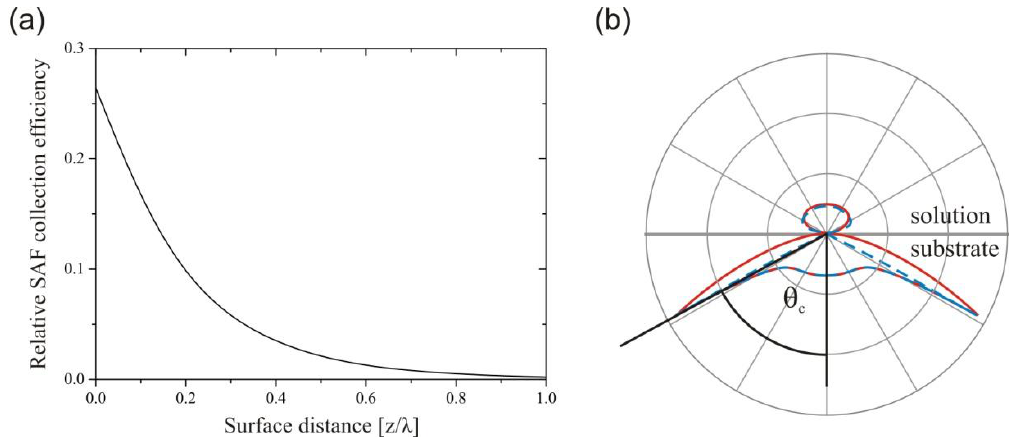
Figure 1. Supercritical angle fluorescence (SAF) emission at the solution/substrate interface. ( a ) The relative SAF collection efficiency of the parabolic element with increasing surface distance z , expressed as a fraction of the emission wavelength, λ. ( b ) Polar plots of the angular emission distribution of a fluorophore with distances z = 0 (red, solid) and z = λ/3 (blue, dashed) from the interface. Adapted from